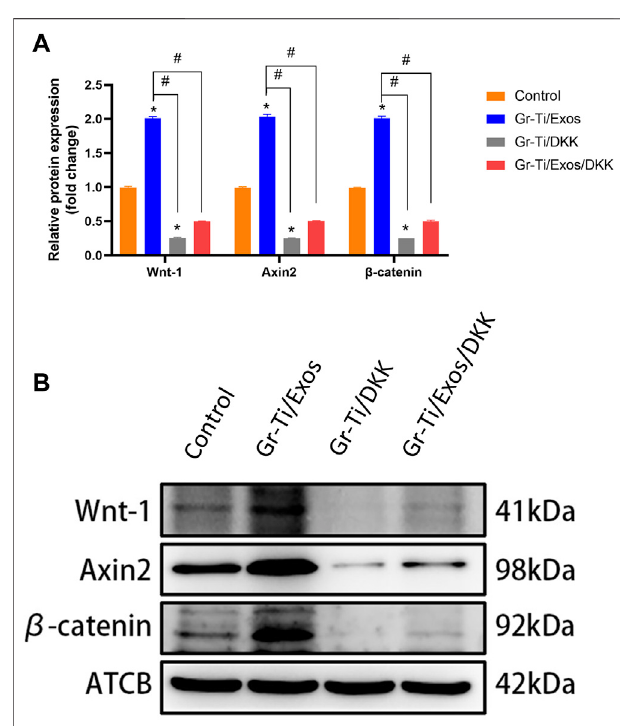
FIGURE 8 | Levels of osteogenic proteins after addition of Wnt pathway inhibitorDKK. (A) RelativeintensityanalysesofWBresults; (B) Theexpression of protein analysed by WB. ( p represents statistical difference between control and other groups; # indicates statistical difference between Gr-Ti/Exos, DKK, and Gr-Ti/Exo/DKK groups; p p < 0.05; # p < 0.05).